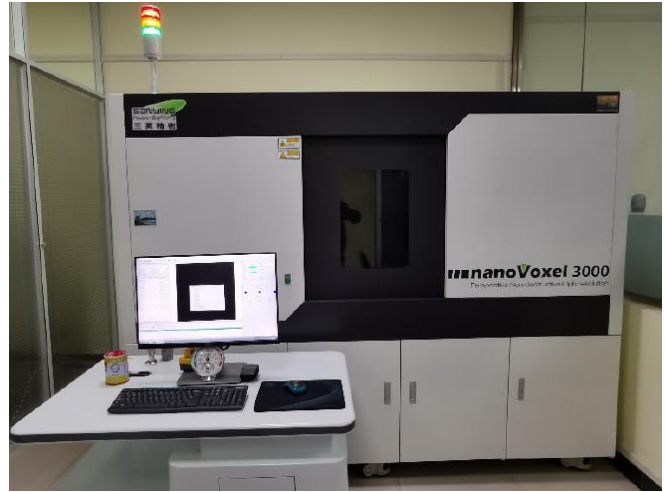
Figure 4. Picture of nano voxel-3000.